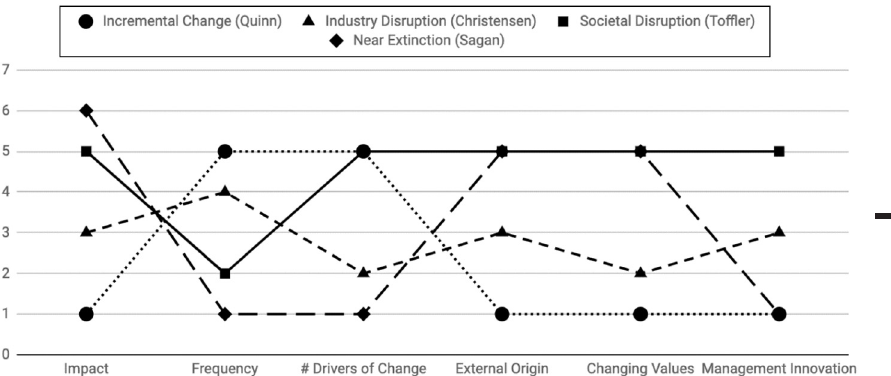
Figure 1. Disruption